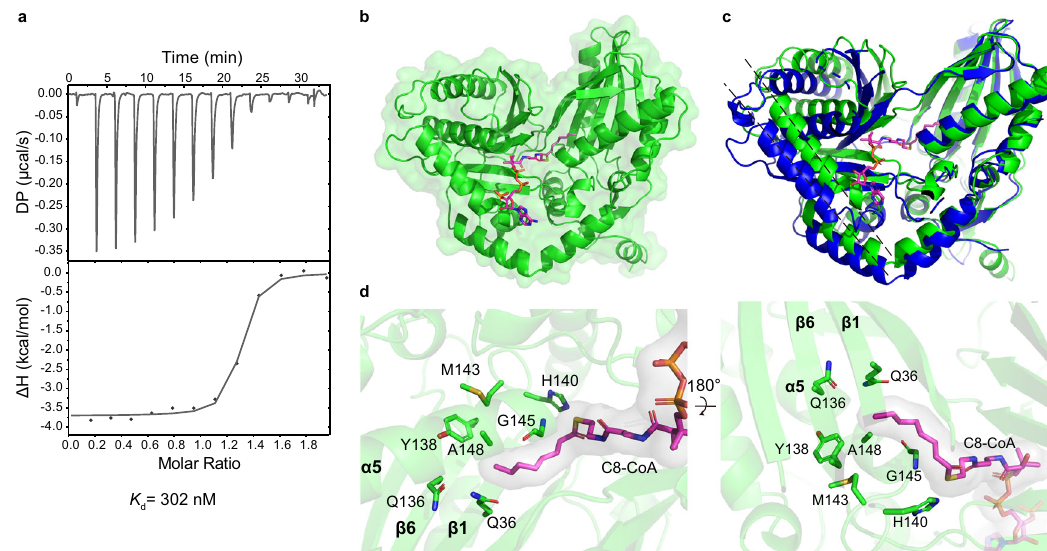
Fig. 6 The co-complex structure of RzmA-Cs R148A with C8-CoA. a Binding af fi nity measurement of C8-CoA to RzmA-Cs R148A using ITC. b Overall co- complex structure of R148A with C8-CoA. c Superimposition of R148A in complex with C8-CoA (green) and R148A unliganded (blue) by their N-lobes, highlighting the conformational changes of Cs domains during substrate binding. d The enlarged views of C8-CoA binding site. All the residues in sticks mode show their side chains only, except for the G145 which does not have a